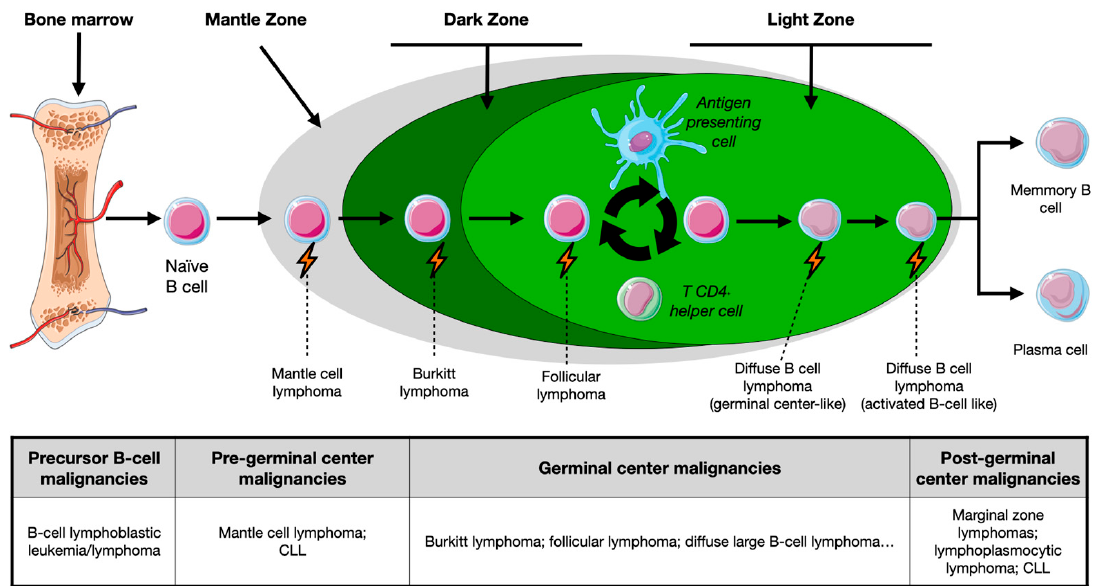
Figure 1. Overview of different stages of B-cell maturation and lymphoproliferative malignancies. Mature B-cell malignancies typically arouse because of cell-intrinsic and cell-extrinsic anomalies by taking advantage of the germinal center biology, notwithstanding that in some instances, naïve B cells carry genetic or chromosomal alterations that arouse earlier than their arrival at germinal centers. CLL—chronic lymphocytic leukemia. Parts of the figure were drawn using pictures from Servier Medical Art (Creative Commons Attribution 3.0).